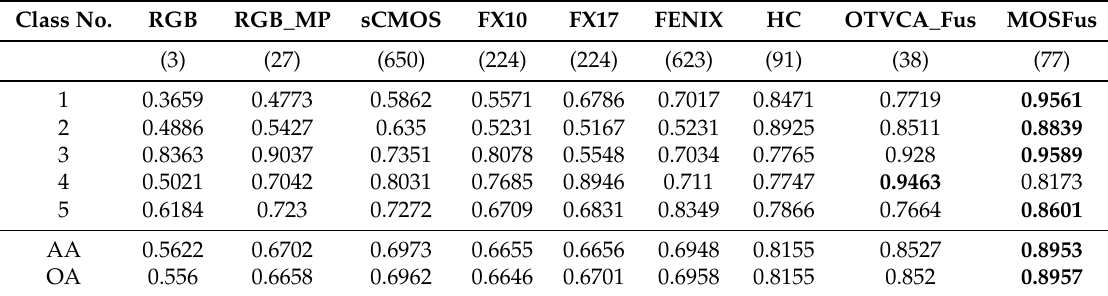
Table 3. The classification accuracies of different fusion techniques and different sensors using SVM applied on the TS4 dataset. The number of features used is given in brackets and the highest accuracy in each row is shown in bold.